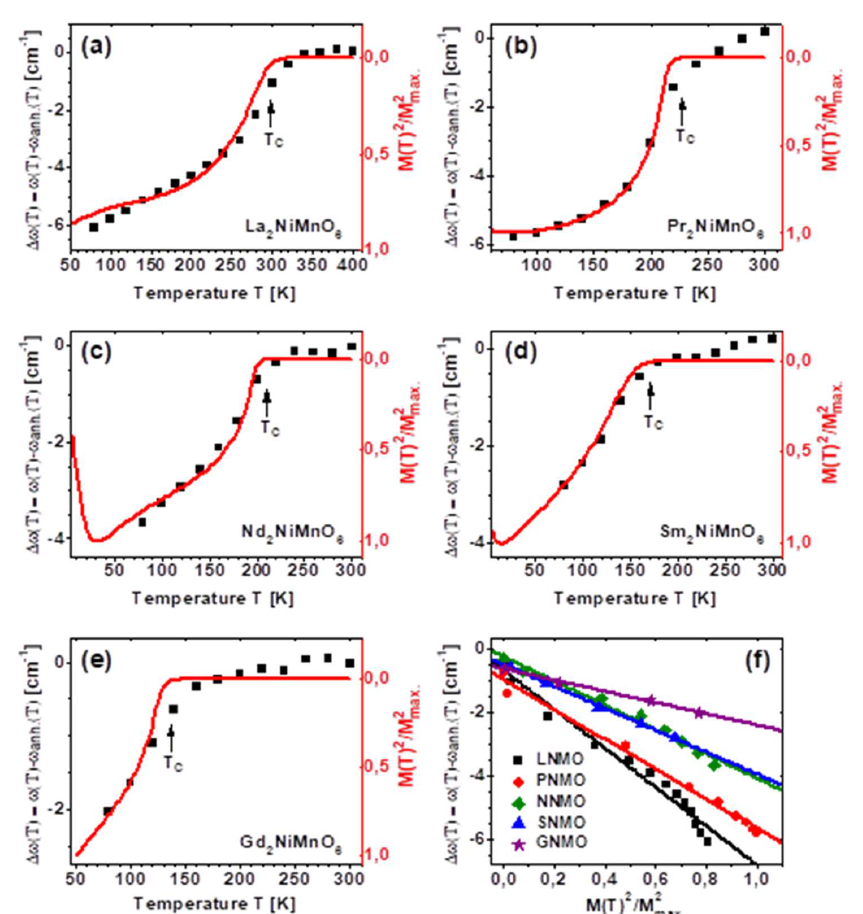
Figure 4. The development of the deviation ∆ ω(T) of the A g breathing mode position from the an- harmonic approximation (phonon renormalization; black data points) and the squared magnetiza- tion M 2 (T)/M 2max with the temperature T for the LCMO ( a ), PCMO ( b ), NCMO ( c ), SCMO ( d ), and GCMO ( e ) double-perovskite thin films on STO(111). Additionally, in ( f ), the corresponding linear approximation between the phonon renormalization ∆ ω(T) and the magnetization M 2 (T)/M 2max is presented for each of the different A 2 CoMnO 6 /STO(111) thin films of the series.